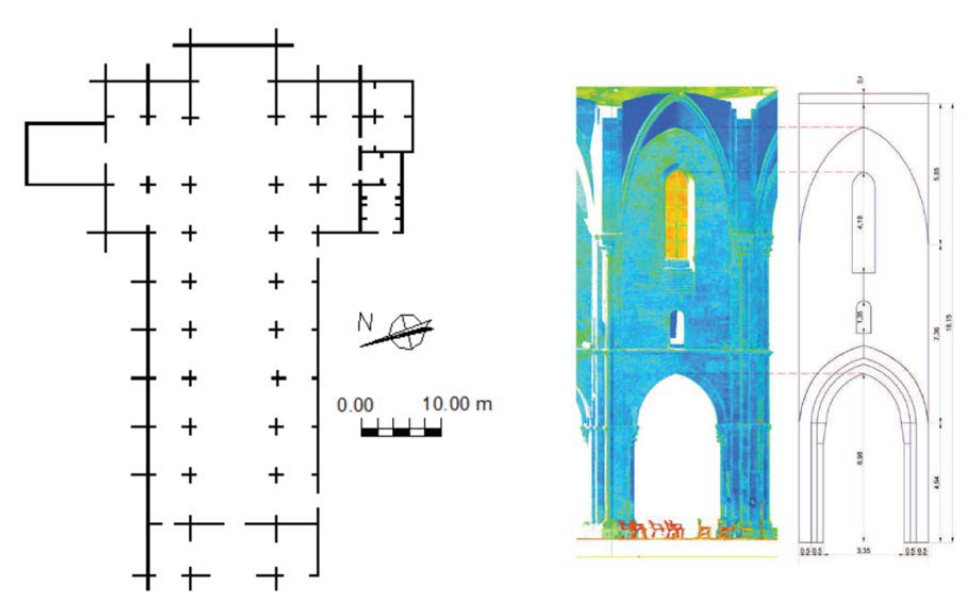
Figure 4. Regularized plan layout of the church (on the left) and drawing geometry from the point cloud (on the right).